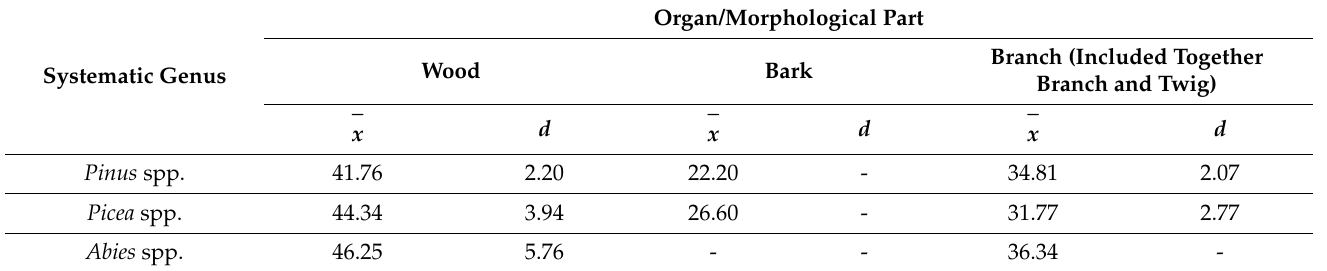
Table A21. Average value and average deviation of the cellulose content (% d.m.) in various organs of particular systematic genera